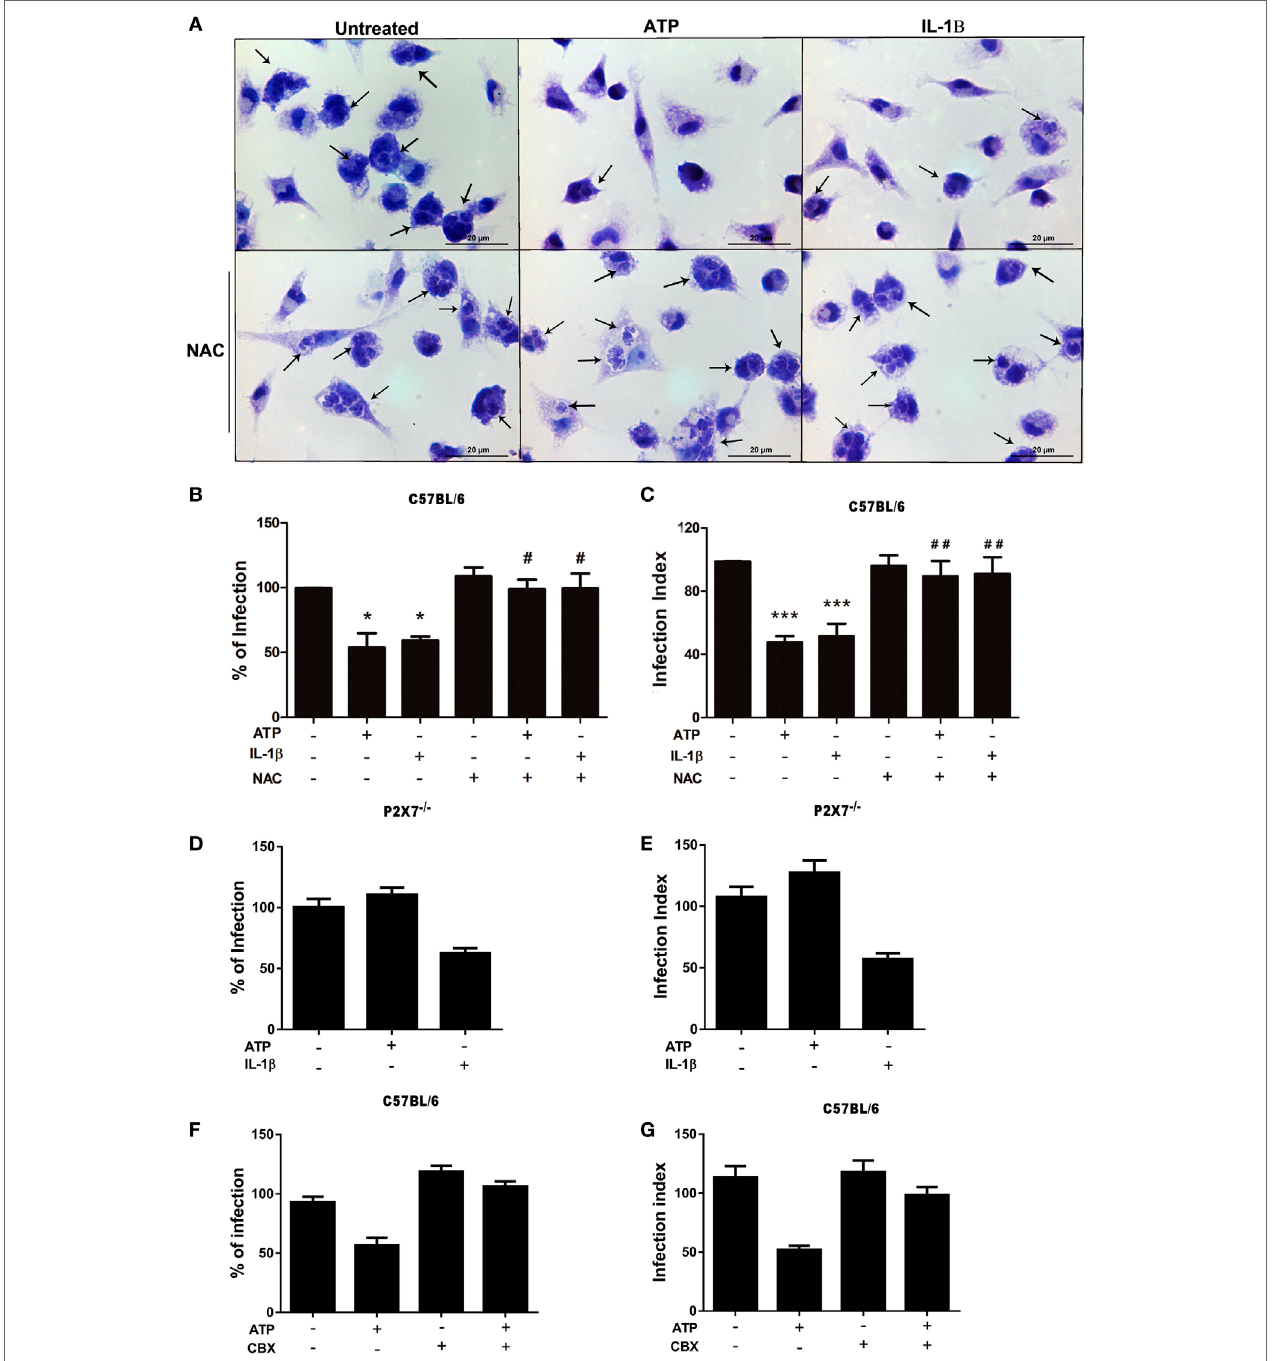
FigUre 5 | The control of T. gondii infection induced by extracellular ATP (eATP) and IL-1 β requires the generation of reactive oxygen species and pannexin-1. Peritoneal macrophages from C57BL/6 (WT) and P2X7 − / − mice were infected with T. gondii tachyzoites for 2 h, and then left untreated or subjected to one or both of the following treatments as indicated: 10 mM N -acetyl cysteine (NAC) or 50 µM carbenoxolone for 40 min, followed by 3 mM eATP or 1 ng/mL IL-1 β for 30 min. Then, cells were incubated at 37°C for a further 18 h, and stained with Panoptic for light microscopy analysis (a) representative images of three independent experiments, which was used to quantify the percentage of infection (B,D,F) and the infection index (c,e,g) in C57BL/6 (B,c,F,g) and P2X7 − / − (D,e) cells. In (a) , black arrows indicate parasitophorous vacuoles containing T. gondii tachyzoites in C57BL/6. Normalized data represent mean ± SEM of three independent experiments [in (B–e) ] and 2 independent experiments [in (F,g) ] performed in triplicates. (F,g) are representative experiments. Treatment with eATP or IL-1 β reduced the parasite load in C57BL/6 cells, and this effect was abolished by NAC pretreatment (B,c) . Treatment with eATP had no effect in the parasite load in P2X7 − / − cells (D,e) or C57BL/6 cells pretreated with carbenoxolone (F,g) . # p ≤ 0.05 and ## p ≤ 0.01 vs. sample treated with ATP only; * p ≤ 0.05 and *** p ≤ 0.001 vs. untreated (by one-way ANOVA followed by Tukey’s